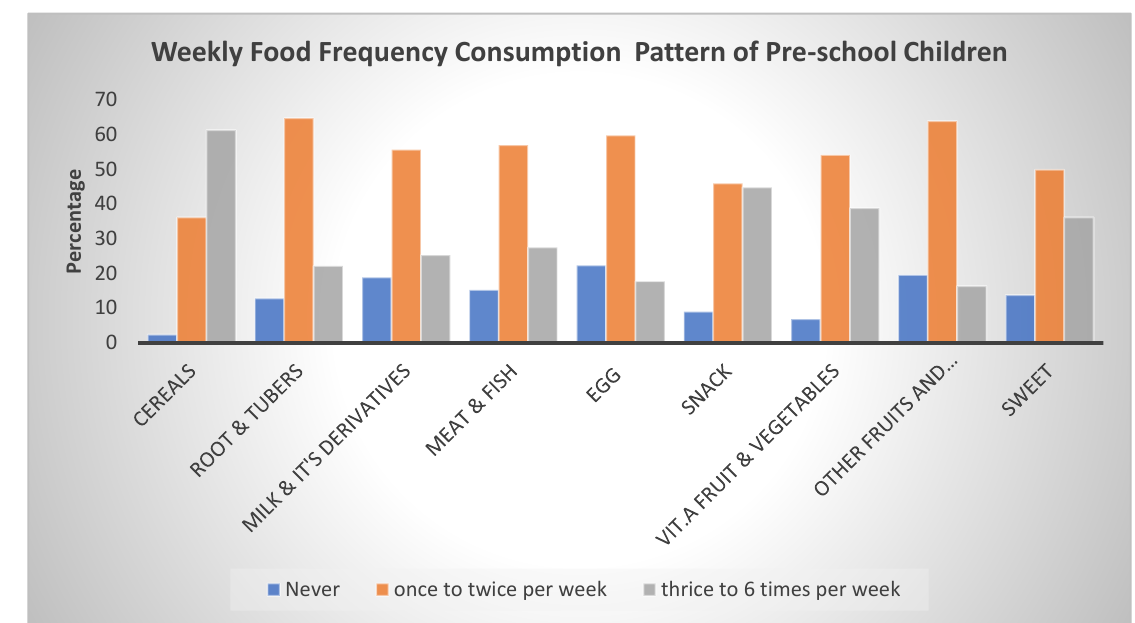
Figure 2. Weekly food consumption patterns of the preschool children in Niger State, Nigeria. Most of the mothers indicated that the starchy staples such as cereals and root and tubers were the most preferred food by the households and thus the most consumed by the preschoolers, (Figure 3). This could be because cereal crops such as rice, millet, and maize are the most cultivated staple food in the study area and thus the most affordable. In the interview held with some of the children, starchy staples such as rice-based and millet-based meals were identified as frequently consumed food groups on a daily basis, which could be because of cultural food preferences and the type of food commonly cul- tivated among farming communities in Niger State. This is in tandem with the findings of Ahmed et al. [46] who reported a similar food consumption pattern among children in Shashemene Ethiopia. Reddy and Dam [59] affirmed that culture and identity play a vital role in food selection, acquisition, consumption, and ultimately nutritional status in any so- ciety, which is in contrast with a similar study conducted in Uganda by Nabuuma et al. [60] where white roots and tubers with bananas were the most consumed food among children.